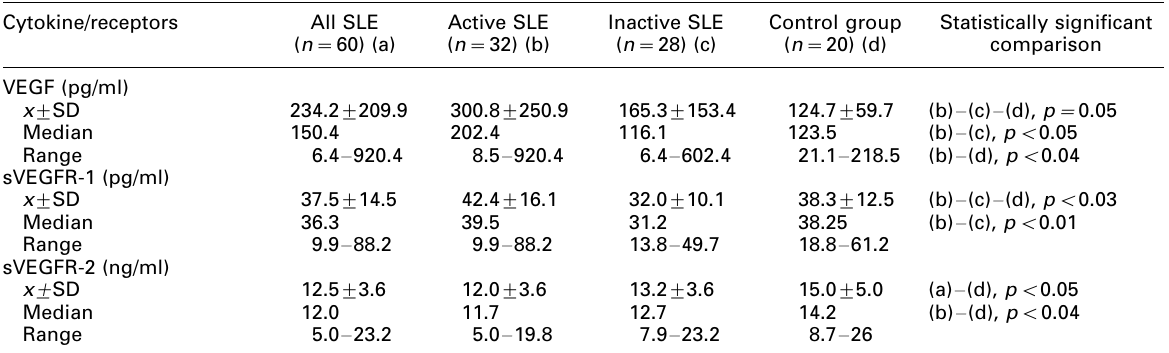
Table 2. Serum levels of VEGF and its soluble receptors (sVEGFR-1 and sVEGFR-2) in patients with SLE and control group